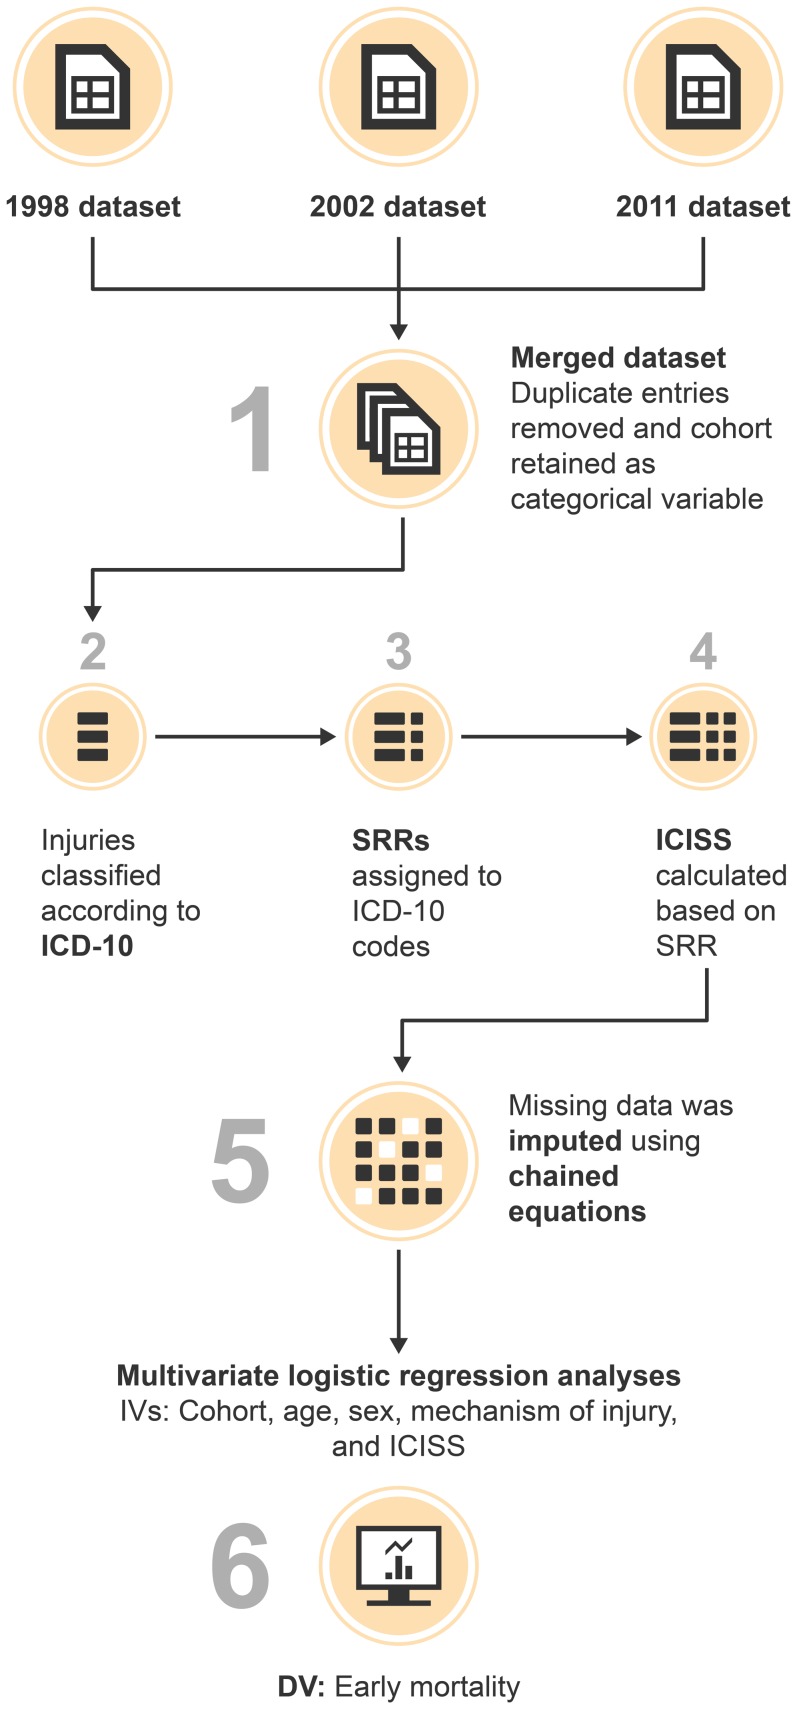
Flowchart providing a simplified outline of the study process.Abbreviations: DV Dependent Variable, ICD International Classification of Disease, ICISS ICD-derived Injury Severity Score, IV Independent Variables, SRR Survival Risk Ratio.